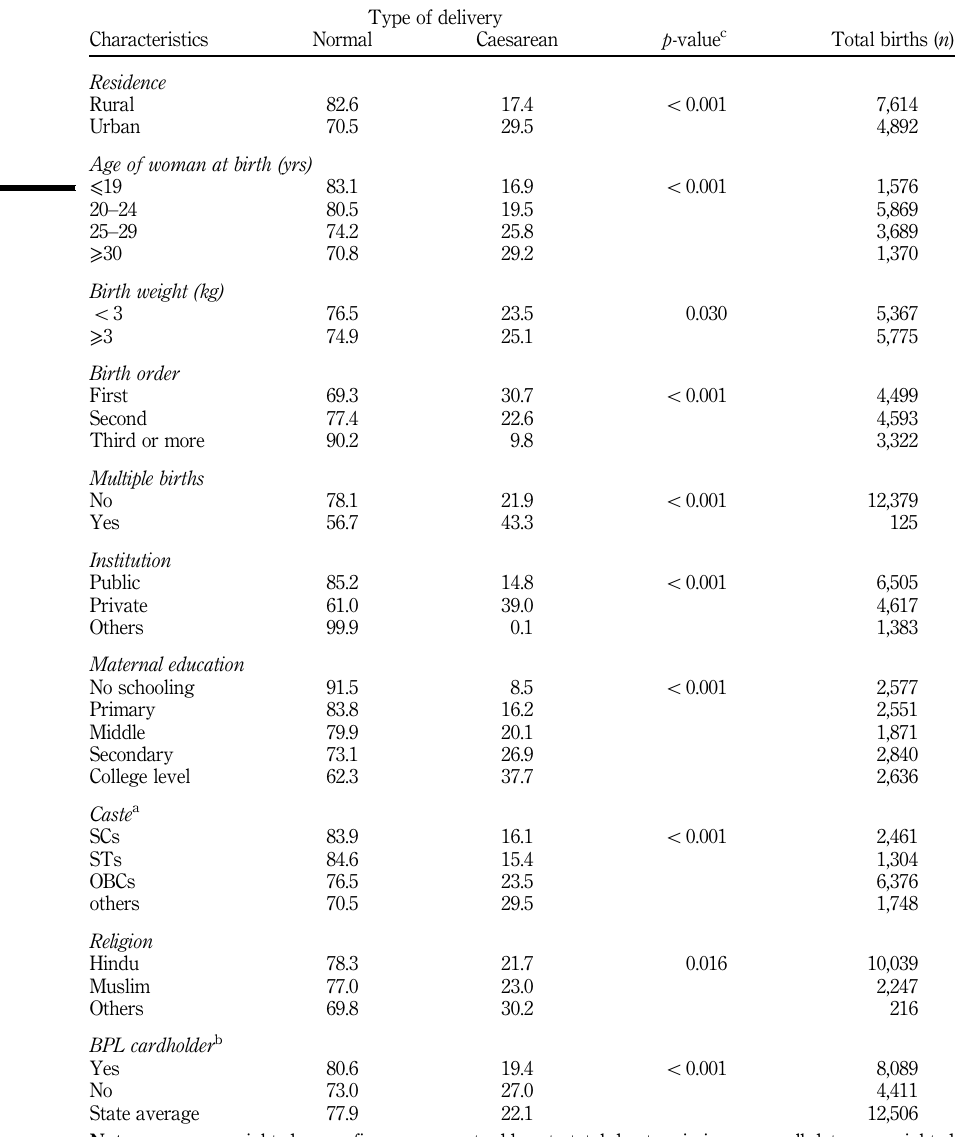
Table III. Prevalence (in percentage) of caesarean deliveries by selected background